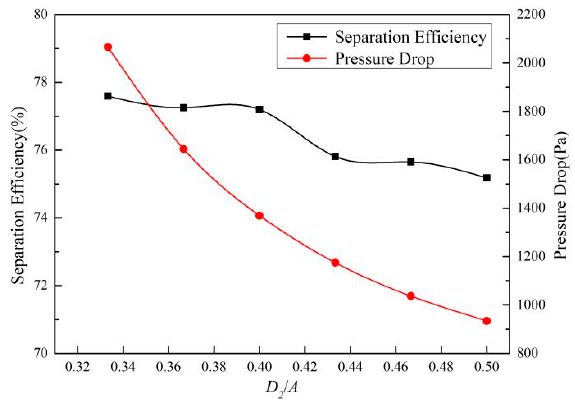
Figure 10. Effect of the gas outlet tube diameter ( D 2 /A ) on efficiency and pressure